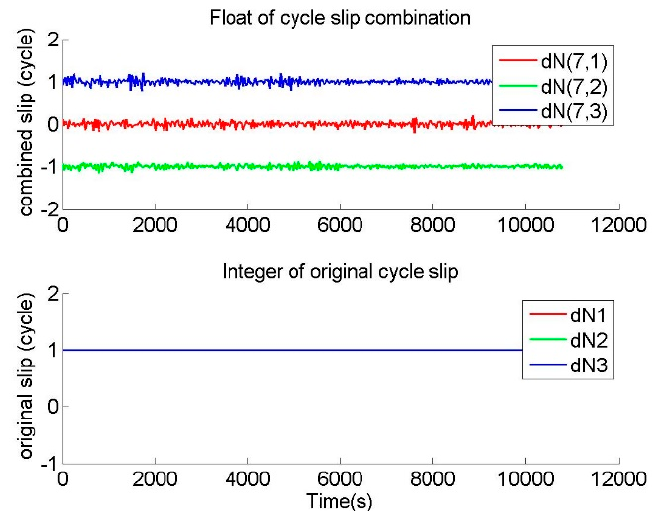
Figure 10. Repair results of the cycle slip combinations and original cycle slips from GTCSR, where the phase data had the known cycle slips of (1,1,1) epoch by epoch on GPS satellite 10 at CUT0 station during the geomagnetic storm that started from UTC 2016/05/08 00:00:00.